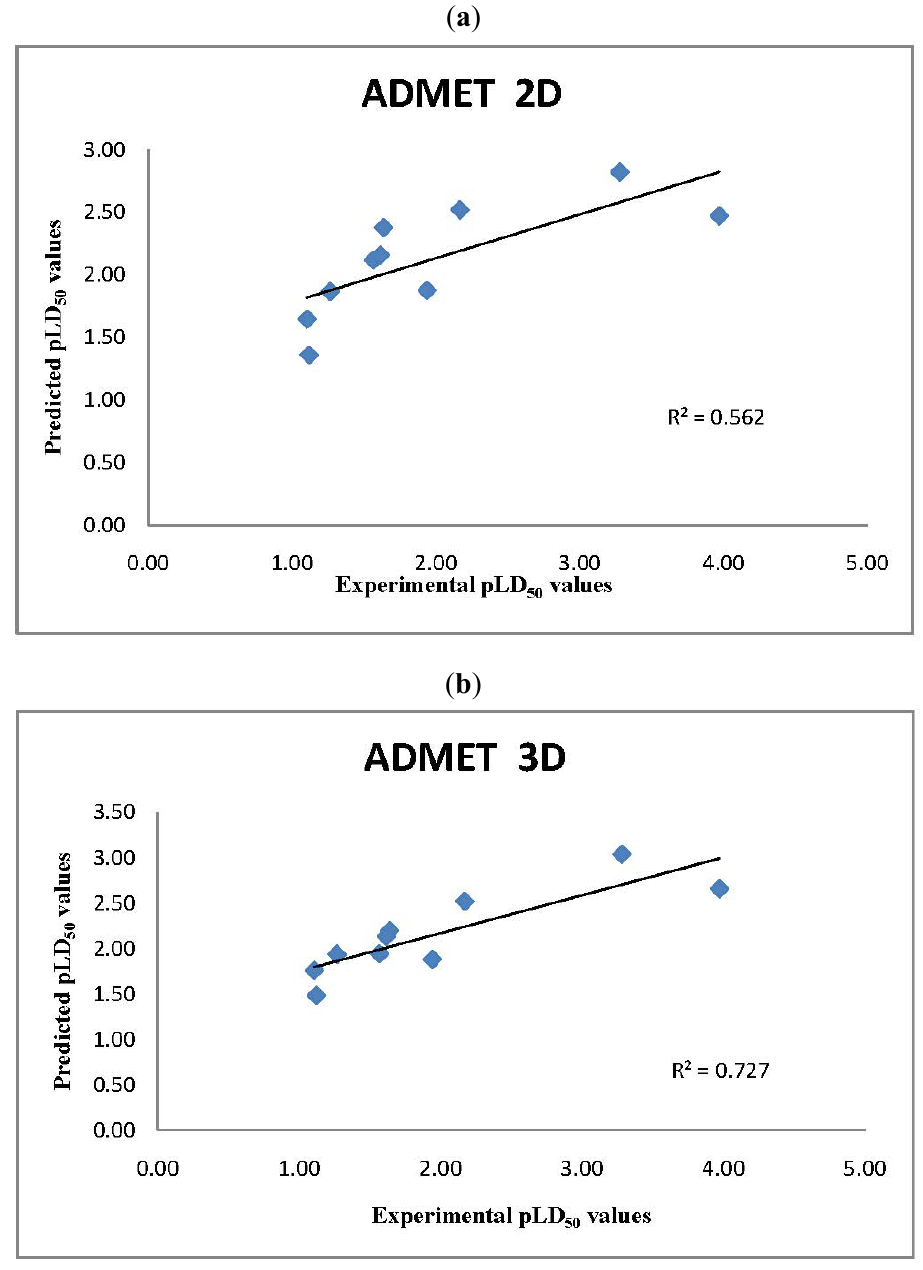
Figure 3. ( a ) Comparison of Experimental pLD50 values with 2D ADMET predictor QSAR pLD model predictions; ( b ) Comparison of Experimental pLD50 values with 3D 50 ADMET predictor QSAR pLD model 50